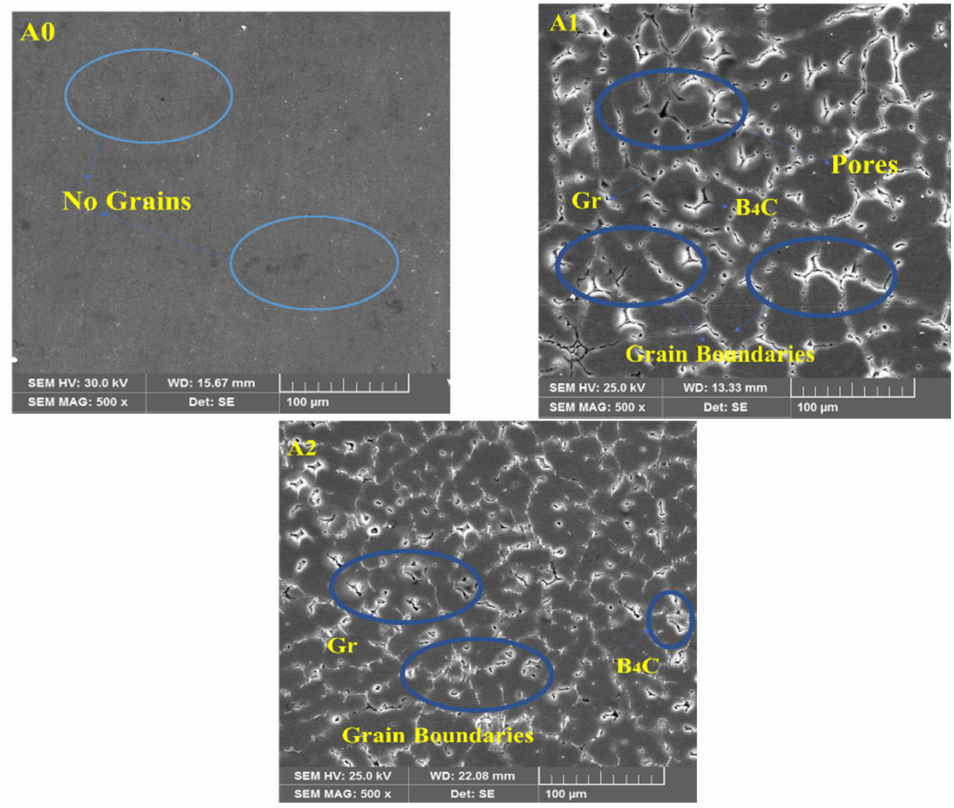
Figure 1. Microstructure of samples (A0) (Al 2618), (A1) (Al 2618 + 5% B 4 C-5% Gr), and (A2) (Al 2618 + 10% B 4 C-5% Gr).